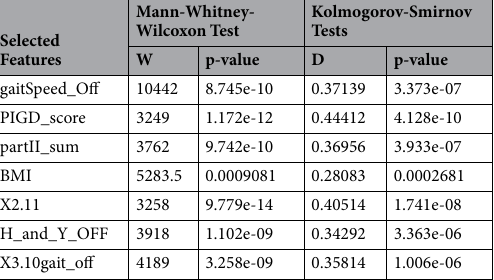
Table 9. MWW test and KS test results for top selected features. Weight is excluded as its p-value > 0.05 in the MWW test.